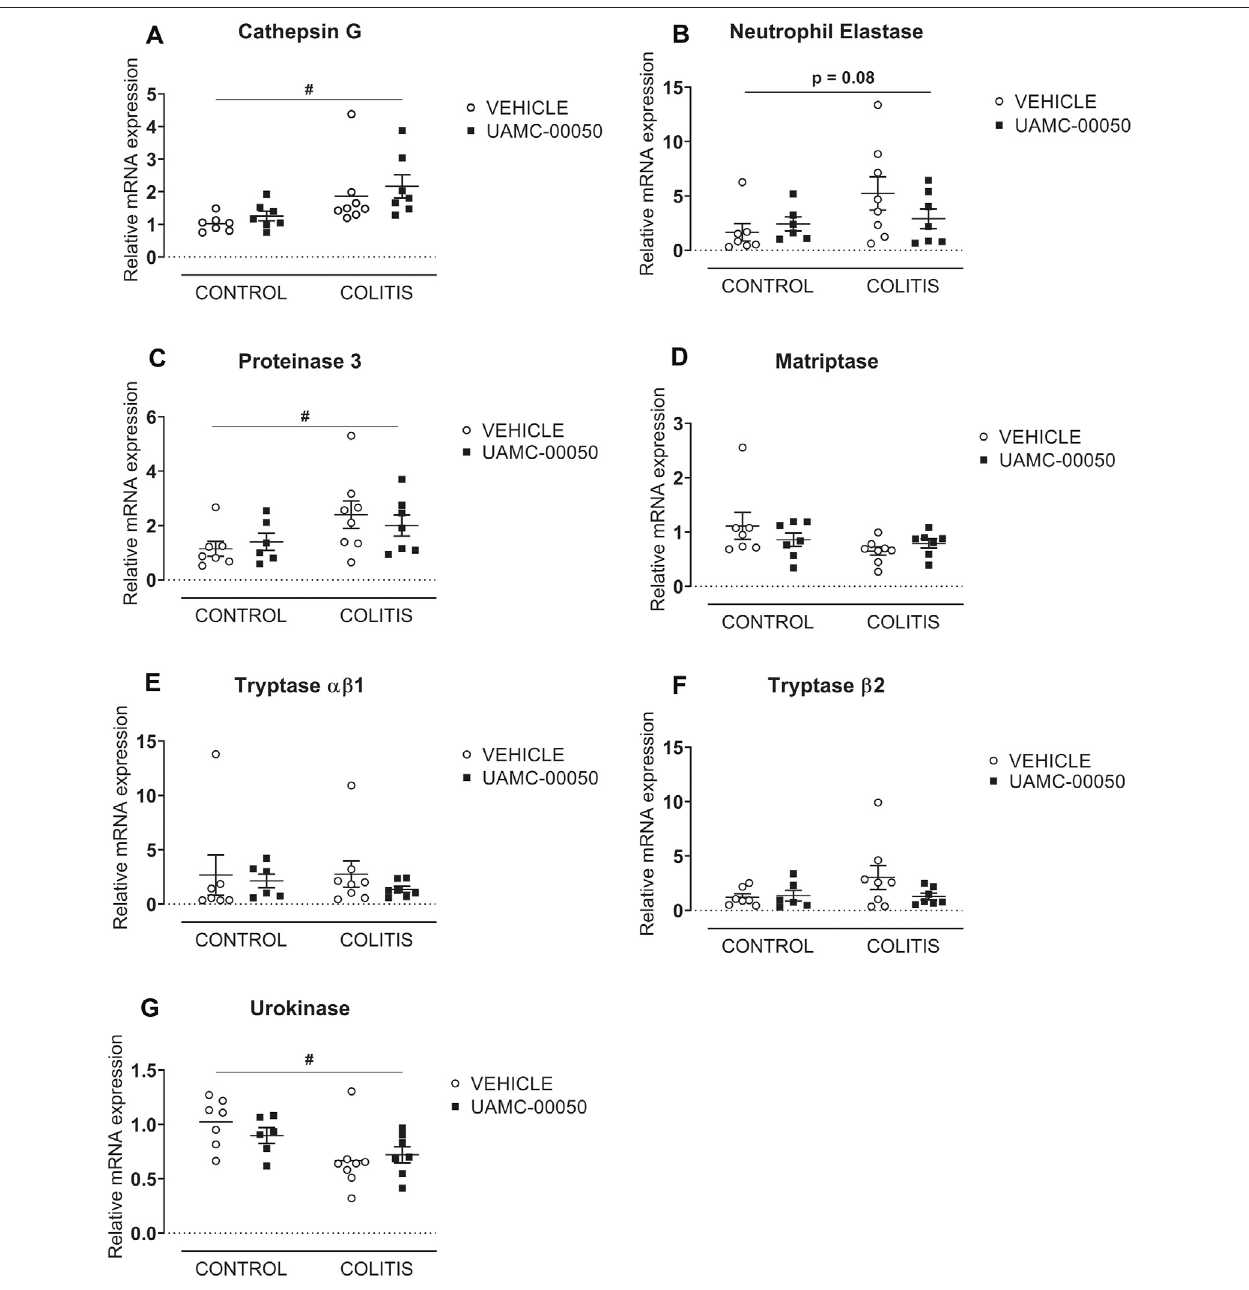
FIGURE 6 | Effect of curative treatment with UAMC-00050 on colonic mRNA expression of serine proteases. Effect on expression of cathepsin G (A) , neutrophil elastase (B) ,proteinase3 (C) ,matriptase (D) ,tryptase αβ 1 (E) ,tryptase β 2 (F) andurokinase (G) .Dataaredeterminedpost-mortematweek4(aftera2-weektreatment with UAMC-00050). Data are represented as mean ± SEM. Two-way ANOVA followed by One-way ANOVA and LSD post-hoc test when appropriate. # p < 0.05; signi fi cant effect of colitis, n (cid:2) 7 – 8/group.